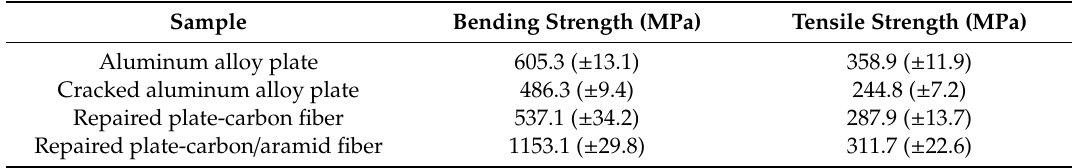
Table 1. Tensile and bending performance of the aluminum alloy plate, cracked aluminum alloy plate, and repaired